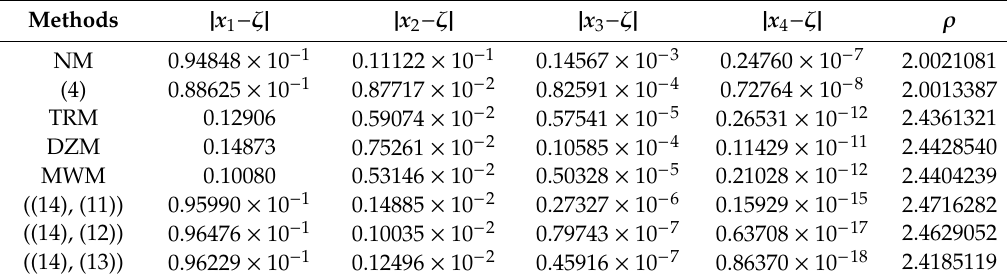
Table 1. Numerical results for function f 1 ( x ) .